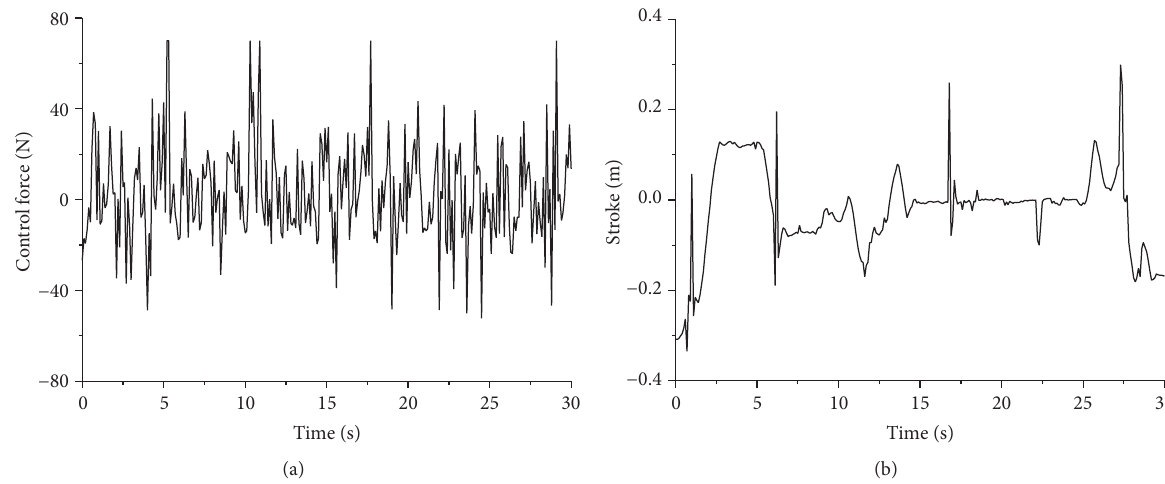
Figure 10: AMD parameters of the 4-order experimental system. (a) AMD control forces. (b) AMD strokes.